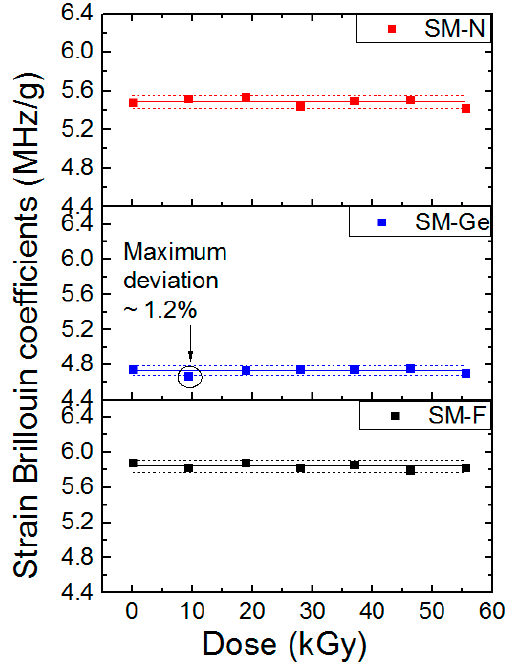
Figure 9. Strain Brillouin coefficients C ε B ’ evolution as a function of dose for the F-doped fiber, Ge-doped fiber and N-doped fiber. The solid line in the middle indicates the average values while the dotted lines highlight a maximum variation of 1.2% for the Ge-doped fiber.